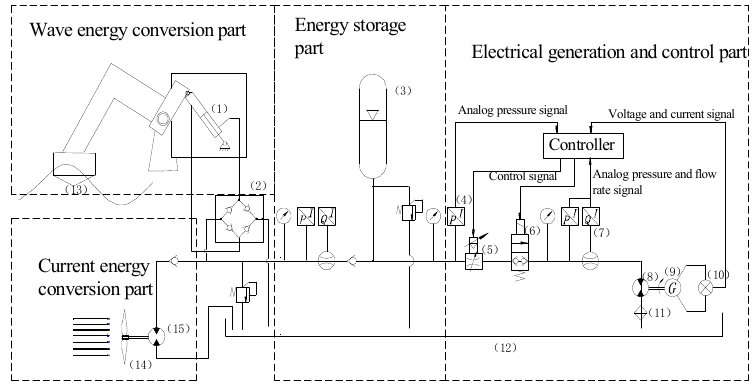
Figure 2. The system schematic of coupling of wave energy and current energy generation with hydraulic energy storage and pressure control. 1. Piston pump; 2. One ‐ way valve manifold; 3. Accumulator; 4. Pressure sensor; 5. Two ‐ way electro ‐ hydraulic proportional flow control valve; 6. Solenoid valve; 7. Flow sensor; 8. Hydraulic motor; 9. Electrical generator; 10. Load; 11. Oil filter; 12. Oil tank; 13. Oscillating buoy; 14. Current capture turbine blade; 15. Hydraulic pump.